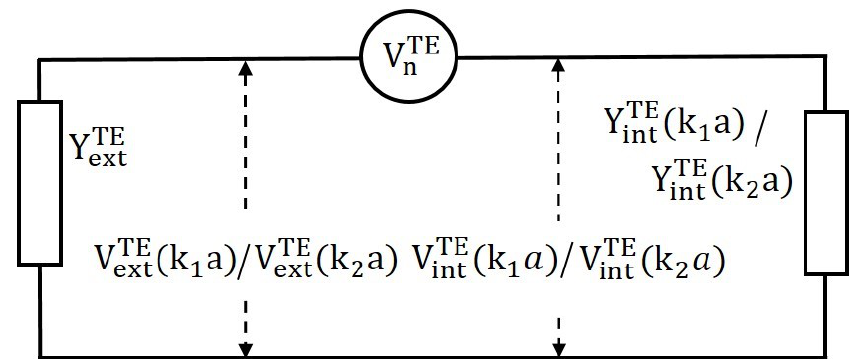
( k ) / V TE ( k ) ) and external ( V TE 2 a 1 a int int